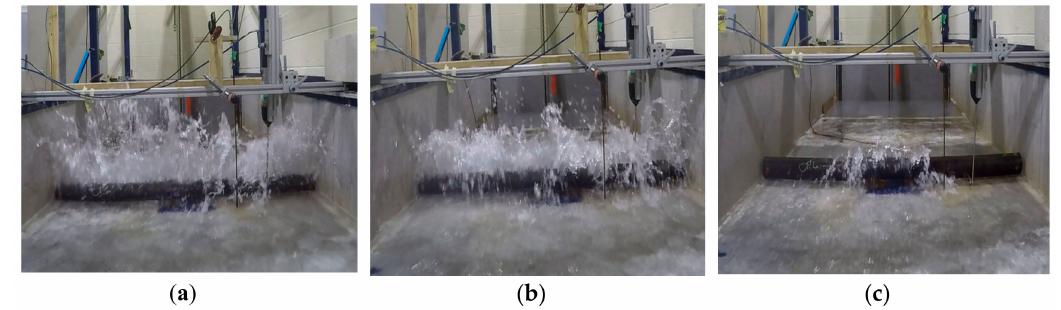
Figure 15. Water level rise at the time of bore impact generated by impoundment depths of ( a ) h = 50 cm, ( b ) h = 40 cm and ( c ) h = 30